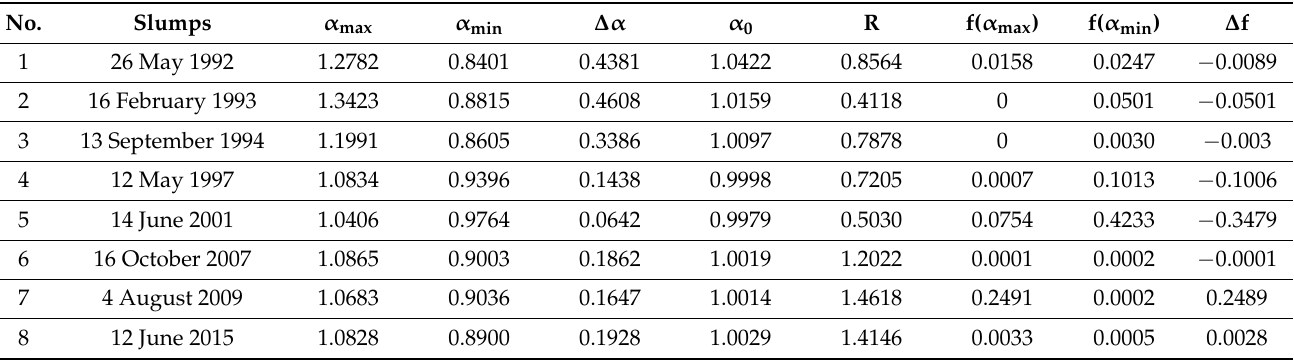
Table 2. The value of ∆ α , ∆ f, and R for the eight